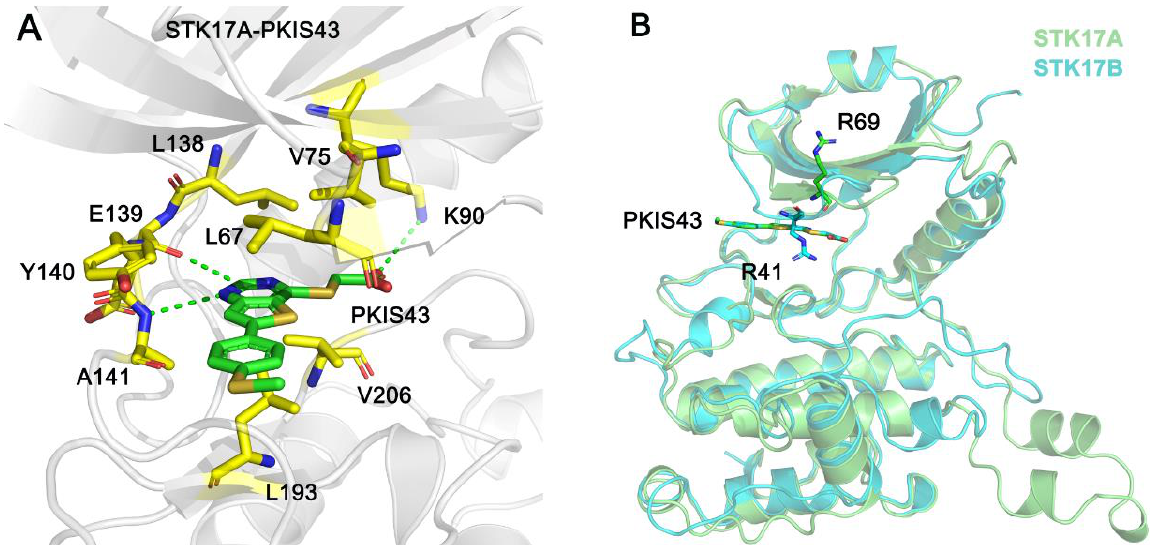
Figure 2. ( A ) The predicted interactions between STK17A and PKIS43. Hydrogen bonds or salt bridge are shown by green dotted lines. ( B ) Structural superimposition between STK17A − PKIS43 and STK17B − PKIS43 complexes.